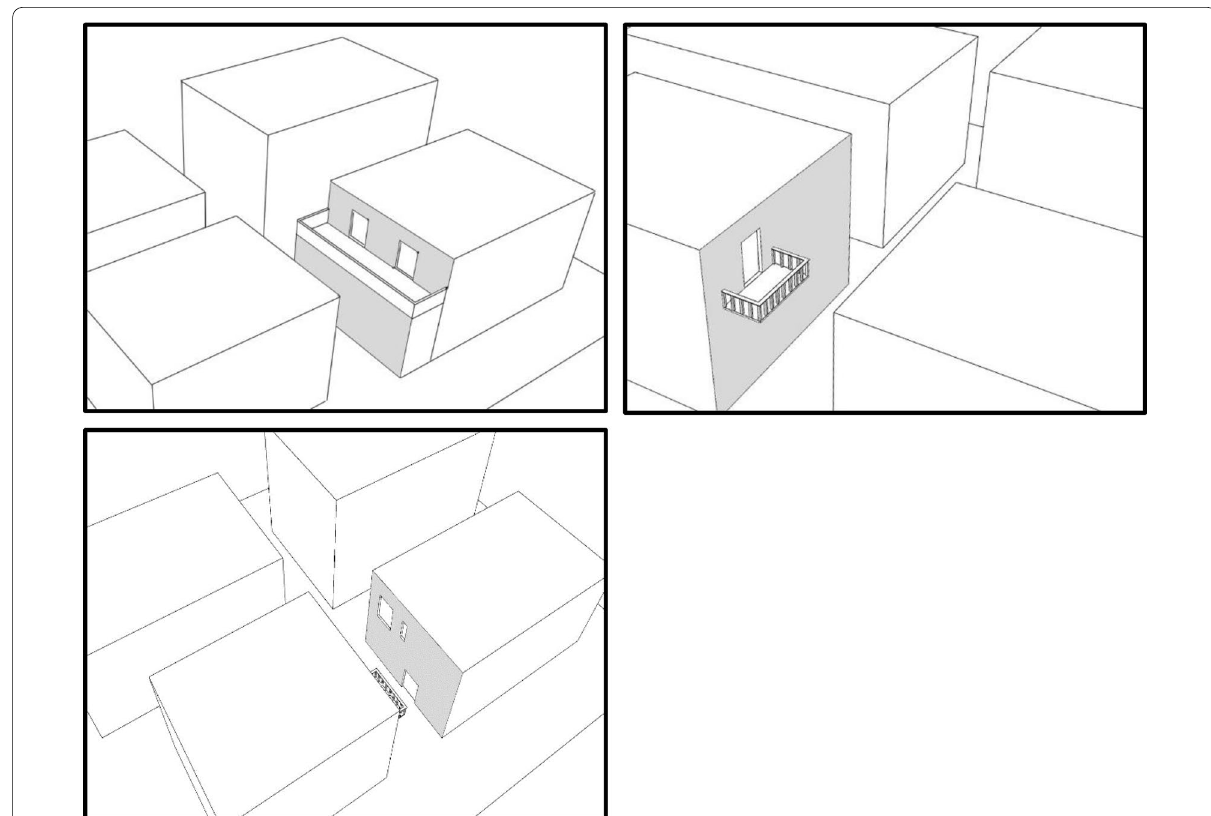
Fig. 5 Design suggestions for placing windows, terraces and balconies on side facades to promote the usage and view to these